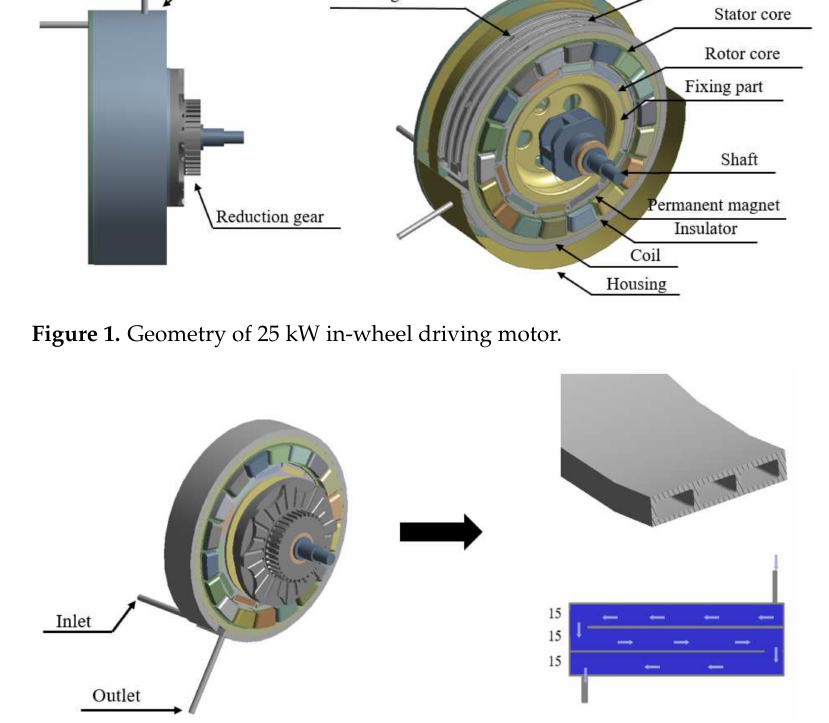
Figure 2. Inlet, outlet, and section of simple water channel model with flow